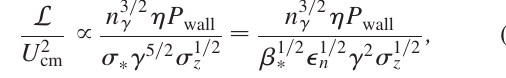
TABLE I. Laser-plasma accelerator plasma density and laser wavelength scalings [6]. Parameter Scaling Accelerating field, E